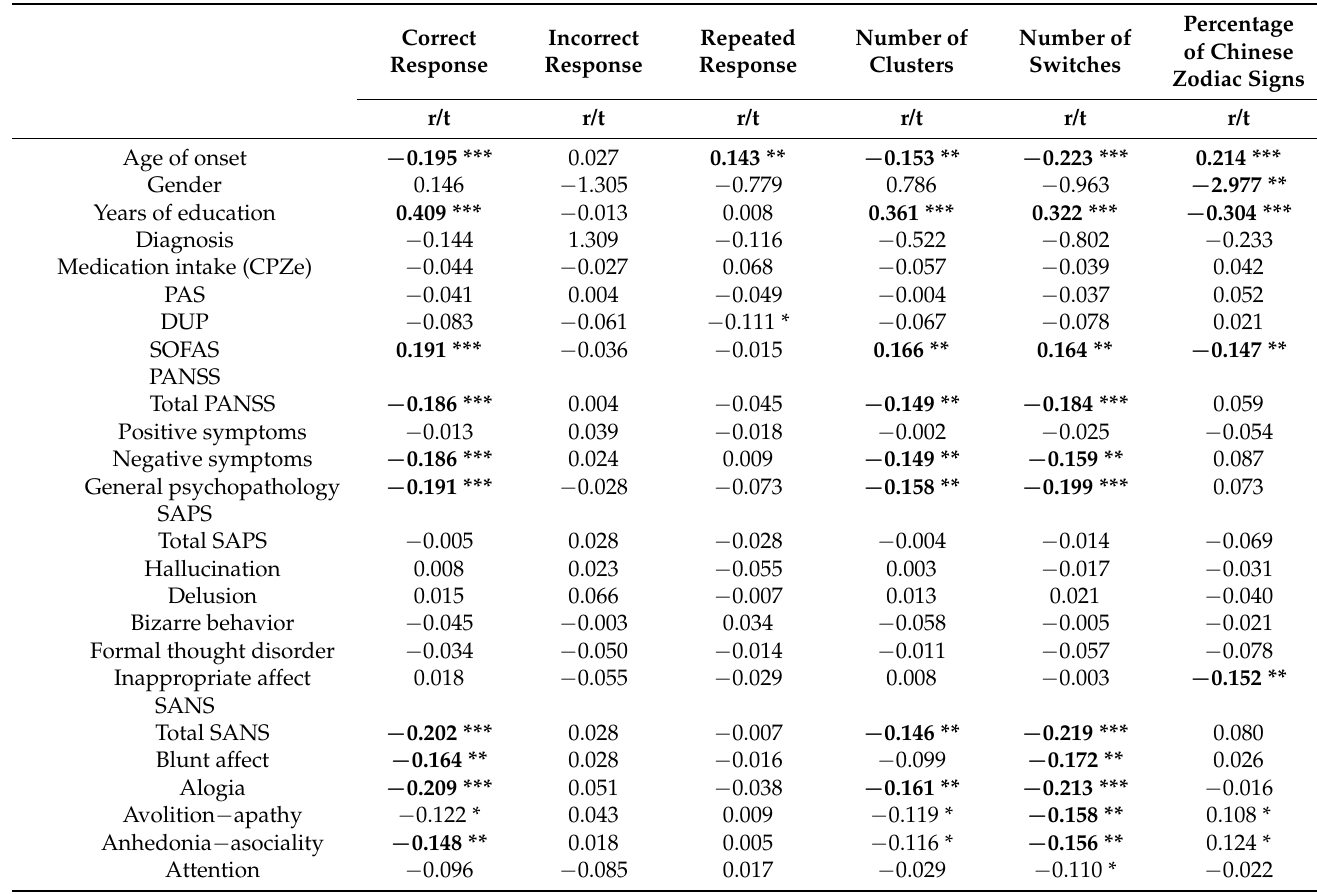
Table 2. Correlation coefficients between clinical assessment and animal fluency performance in